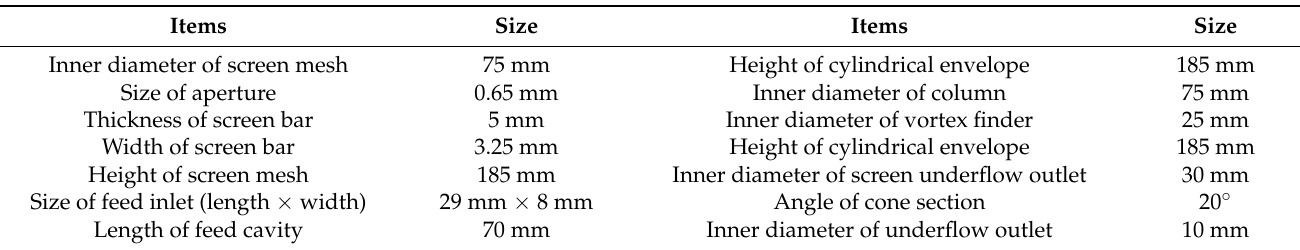
Figure 5. Distribution of static pressure near the cylindrical screen. Table 1. Structure size of